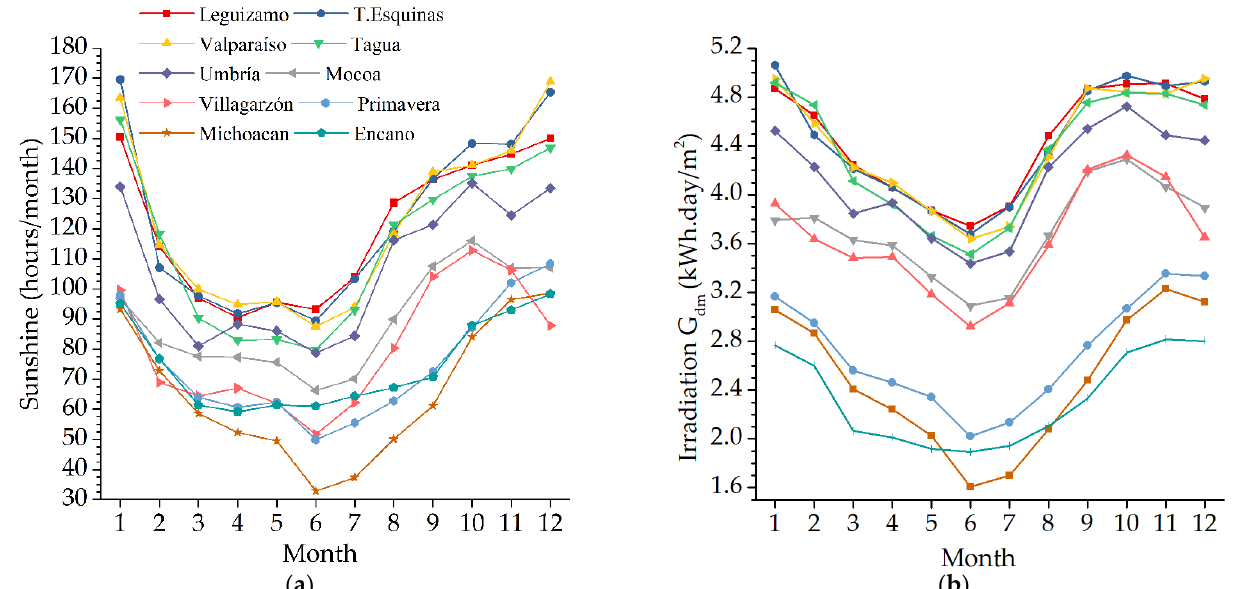
Figure 4. Results of data from IDEAM weather stations: ( a ) Average hours of sunshine per month; ( b ) Average daily solar irradiation per month.